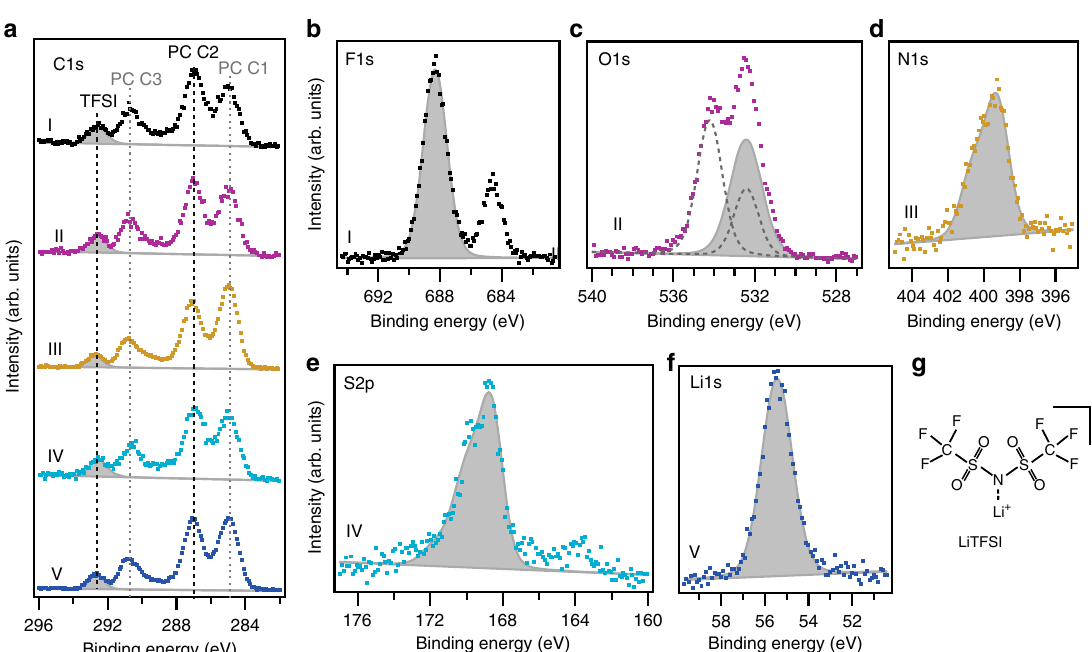
Fig. 2 APPES data for composition analysis of 1 M LiTFSI in PC electrolyte. C 1s ( a ), F 1s ( b ), O 1s ( c ), N 1s ( d ), S 2p ( e ), and Li 1s ( f ) spectra of the Elect- Drop sample (1 M LiTFSI electrolyte on Li metal). The shaded areas represent the respective TFSI contributions in case of overlapping signals. The roman numerals indicate different measurement spots. The molecular formula of LiTFSI is shown in ( g )